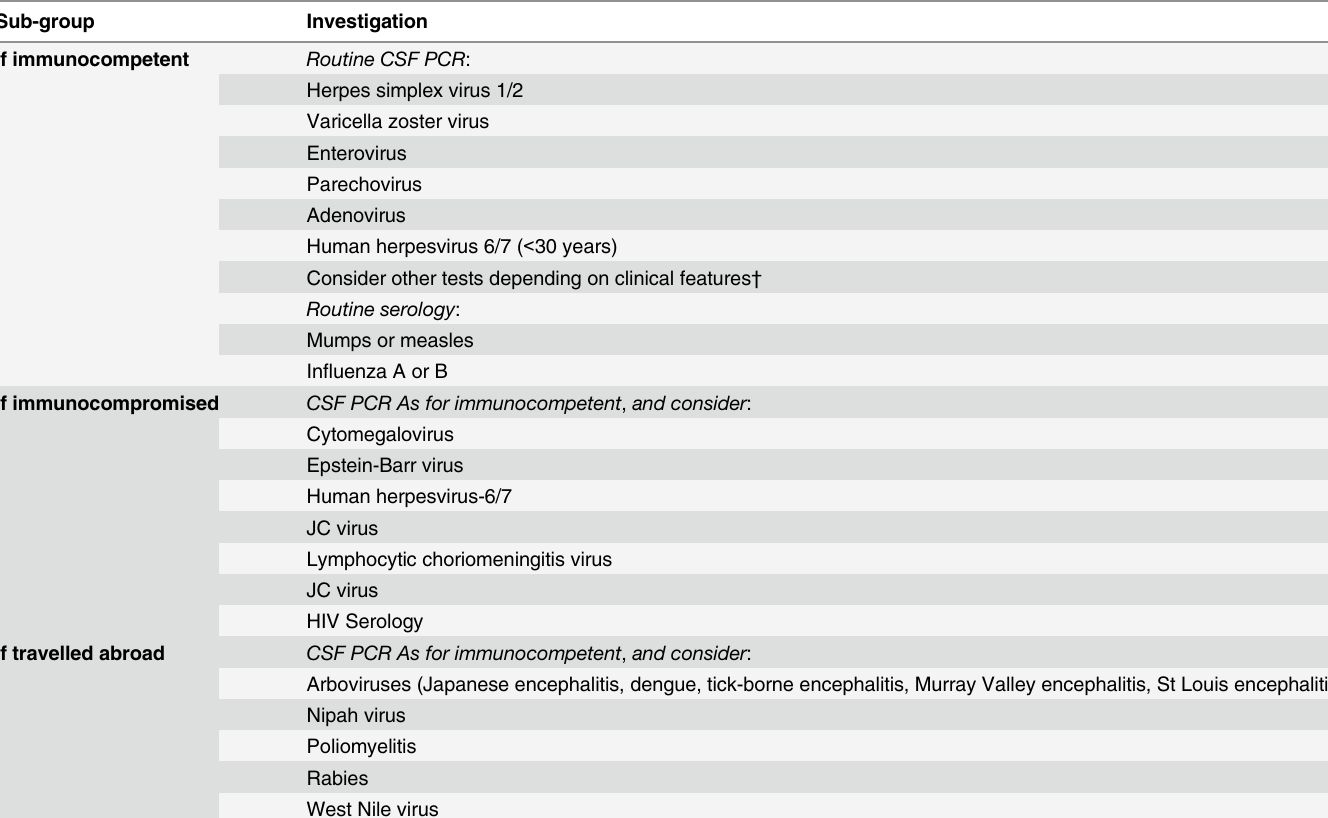
Table 1. First line testing for all patients with encephalitis recruited through the prospective HPA Study of the Aetiology of Encephalitis in England * .